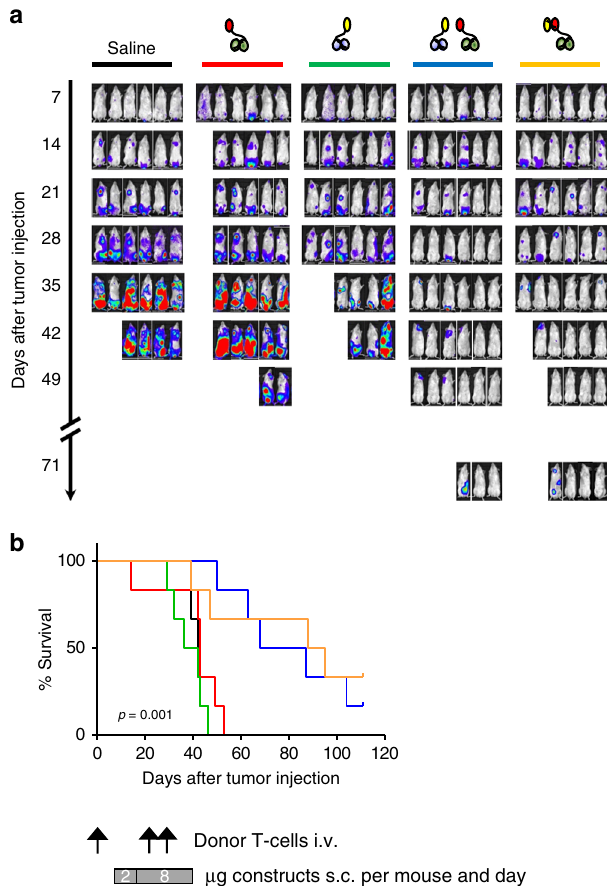
Fig. 4 High precision cancer cell targeting in vivo. Immune de fi cient mice (6 per group) were challenged with 1 × 10 6 luciferase-positive THP-1 (CD45 and HLA-A2 positive) tumor cells intravenously (i.v.) on day 1. HLA-A2 negative memory CD4 and CD8 donor T lymphocytes were added i.v. on day 1, 22, and 28. After tumor engraftment on day 7, mice were treated subcutaneously with either saline (PBS), individual hemibodies addressing CD45 or HLA-A2 antigens, the combination of both hemibodies, or the HLA-A2 targeting BiTE control with a starting dose of 2 µ g/mouse per day for 1 week, followed by 8 µ g/mouse per day at distant sites until day 39. a Tumor burden of luciferase-positive THP-1 cells were assessed on a weekly basis by IVIS Lumina XR Real-Time Bioluminescence Imaging and b survival was monitored daily until day 110. Signi fi cance was determined by the Kaplan – Meier estimator; p = 0.0017 for the hemibody combination versus V L α CD3-scFv α HLA-A2, p = 0.0005 for the hemibody combination versus V H α CD3-scFv α CD45. No signi fi cant difference for the hemibody combination versus the bispeci fi c BiTE control, p = 0.6670. The data represent one experiment, statistical considerations on effect and group size are provided in Supplementary Table